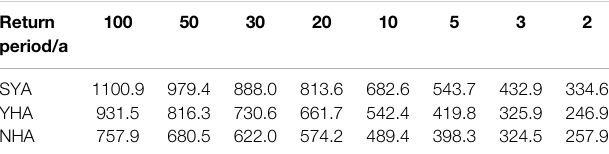
TABLE4| PrecipitationduringMeiyuandHuang-HuairainyseasonsinSYA,YHA, and NHA for some typical return periods (unit: mm). Return